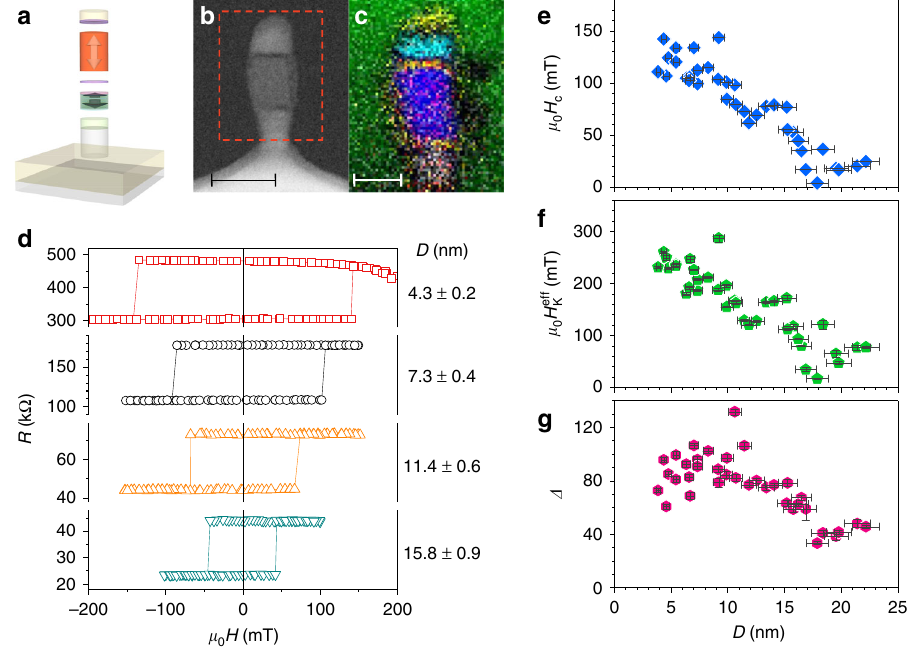
Fig. 3 Magnetic fi eld characterization of nano MTJs. a Schematic image of the nano MTJ, where the arrows show the expected magnetic easy axis. b Cross-sectional high-angle annular dark- fi eld scanning transmission electron microscopy images of a MTJ after the ion milling process. Broken rectangle indicates the area for element mapping shown in c . The scale bar corresponds to 20 nm. c Corresponding image of element mapping using electron energy- loss spectroscopy. Representations of each color are B: red, N: green, O: yellow, Fe: dark blue, Co: white, Ru: light blue. The scale bar corresponds to 10 nm. d MTJ resistance R in response to perpendicular fi eld H ( R – H curves) for MTJs with various diameters D . e – g MTJ properties as a function of D . e Coercive eff and g thermal stability factor Δ . Error bars represent s.e.m, where those along the horizontal direction fi eld H fi eld H C , f effective magnetic anisotropy K originate from uncertainty in determination of resistance-area product and those along the vertical direction originate from the fi